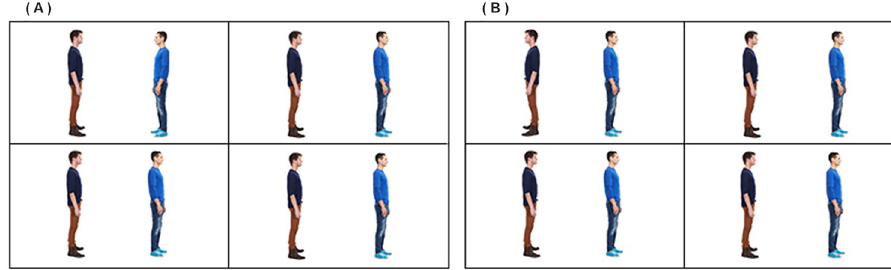
Fig 1. Social priority effect in the visual search array employed from Experiment 1 of Vestner et al. [1]. Detection of the target in the top-left location is faster when the pair are facing (Panel A) than when back-to-back (panel